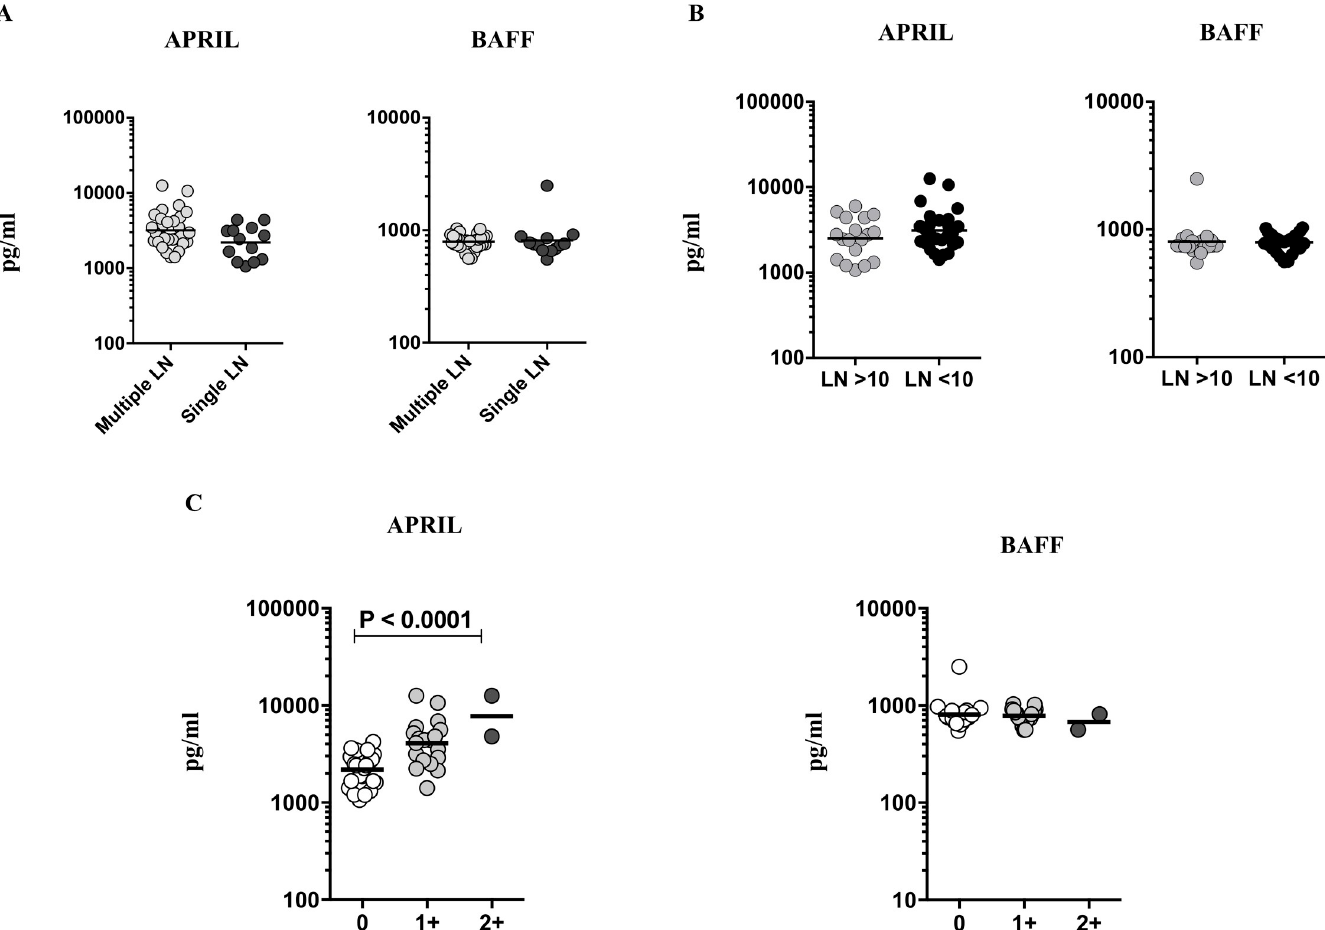
Fig 4. Positive association of circulating levels of B cell growth factor (APRIL) with lymph node (LN) culture grades of TBL individuals. (A) The plasma levels of B cell growth factors (APRIL and BAFF) in TBL individuals with the multiple and single LN. (B) The plasma levels of APRIL and BAFF in TBL individuals were correlated with LN size. Results were shown in scatter plots, with each circle representing a single individual and the bars indicating the geometric means. P values were calculated using the Mann-Whitney U test. (C) The relationship between the APRIL and BAFF plasma levels with LN culture grades were measured in TBL individuals. The data are denoted as scatter plots, with each circle representing a single individual and the bars indicating the geometric means. P values were calculated using linear trend post-test analysis.